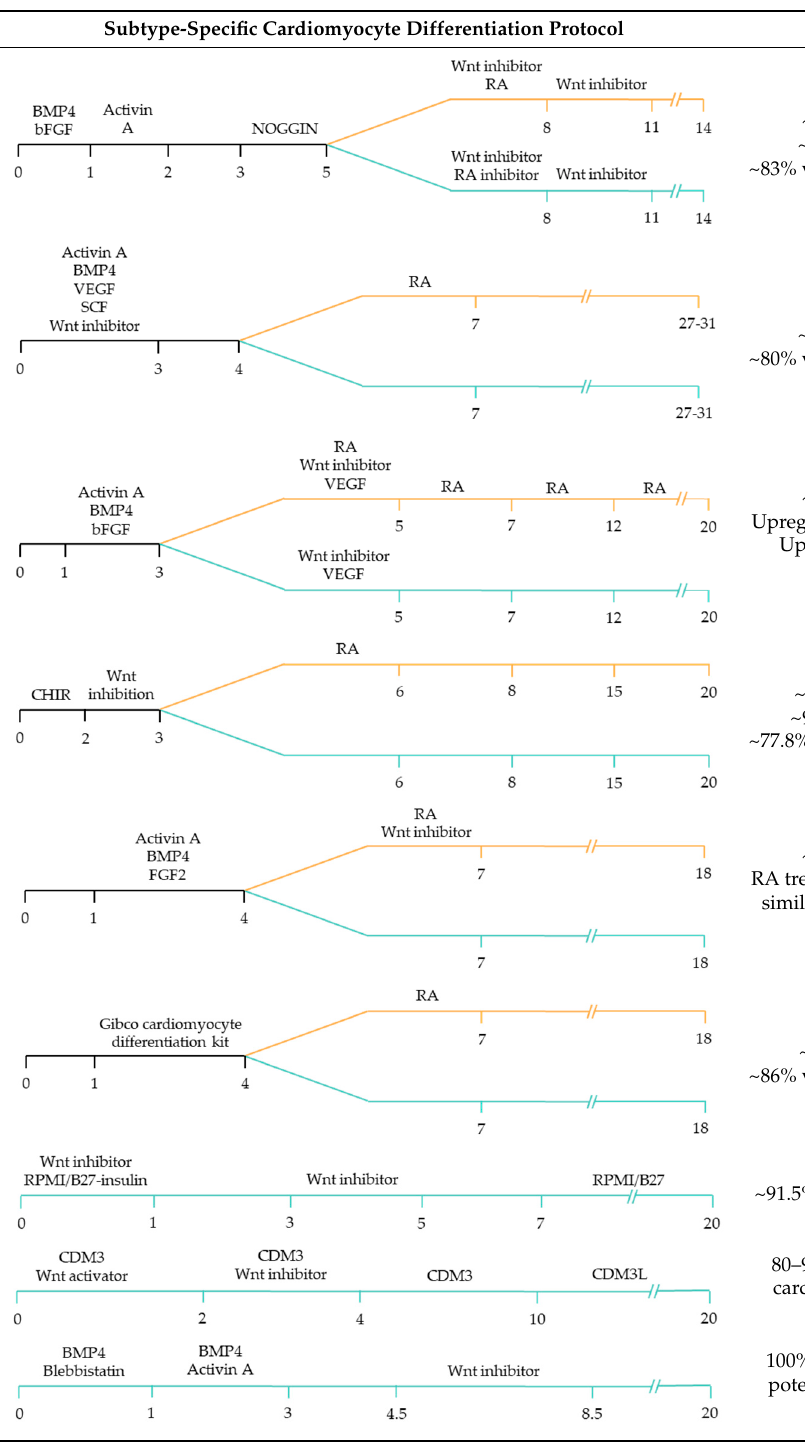
Table 1. Overview of protocols for the generation of subtype-specific cardiomyocytes involving the manipulation of cardiac development signalling pathways.